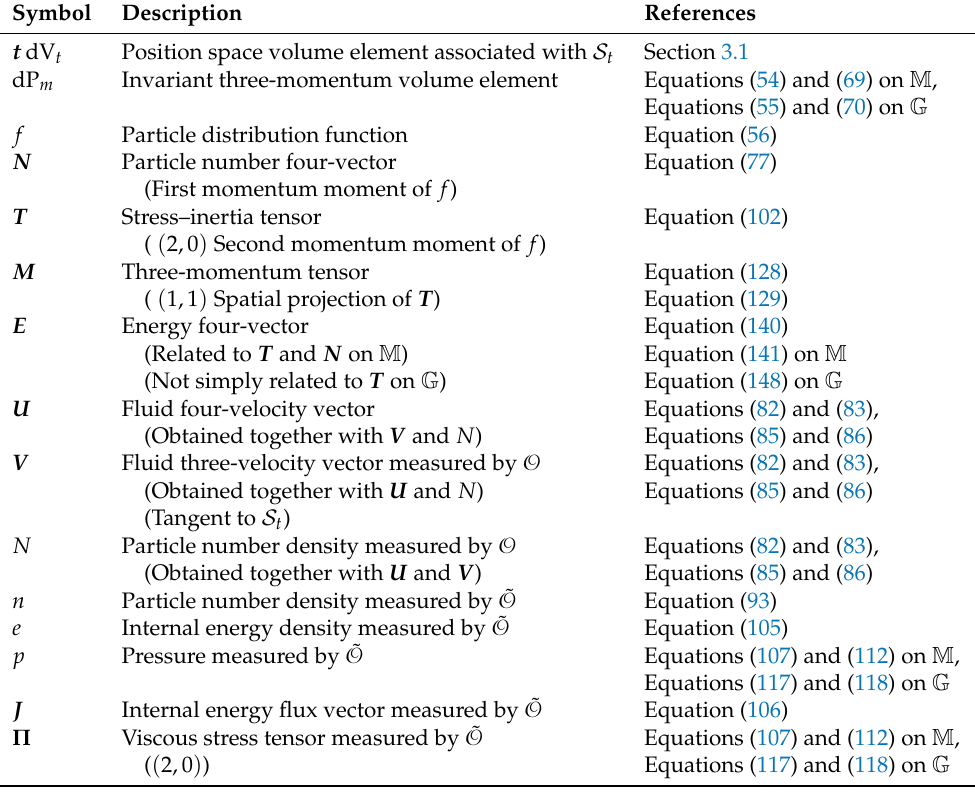
Table 3. Geometric entities characterizing a simple fluid on Minkowski and Galilei/Newton